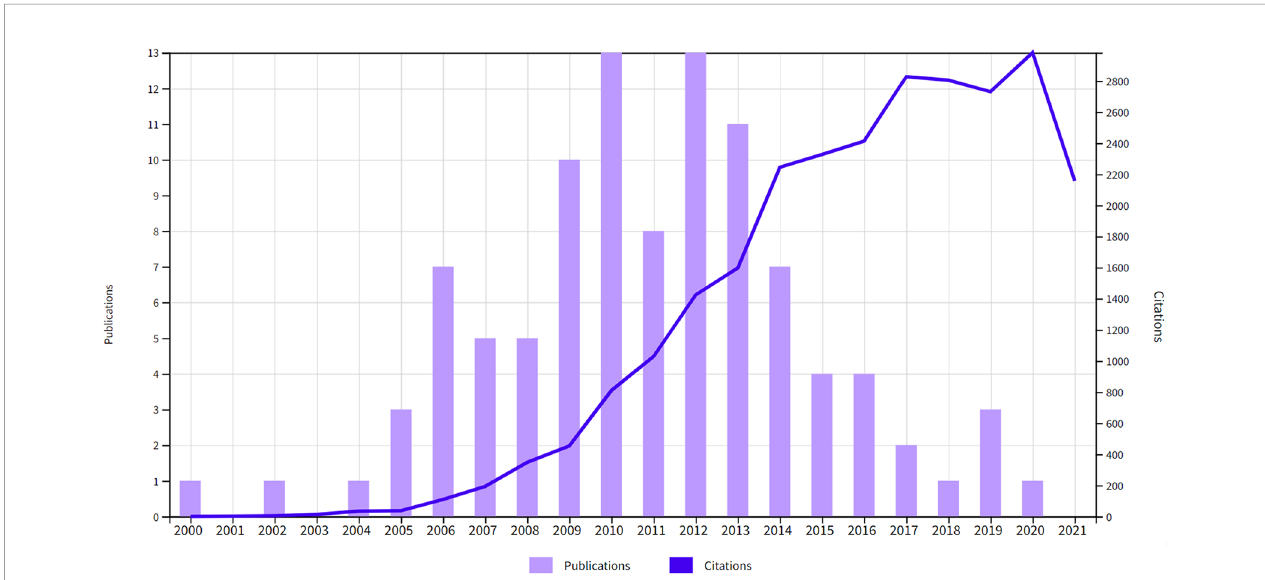
FIGURE 1 | The publication time and citations distribution of the 100 most cited papers in